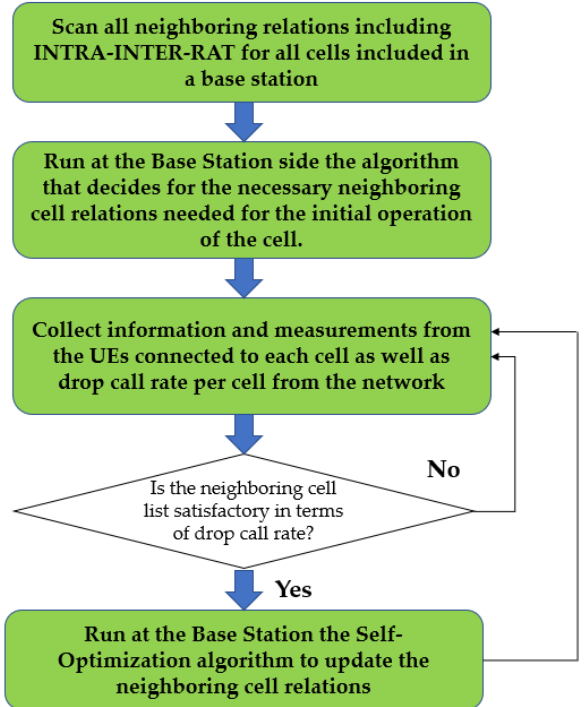
Figure 7. Self-configuration and self-optimization process.